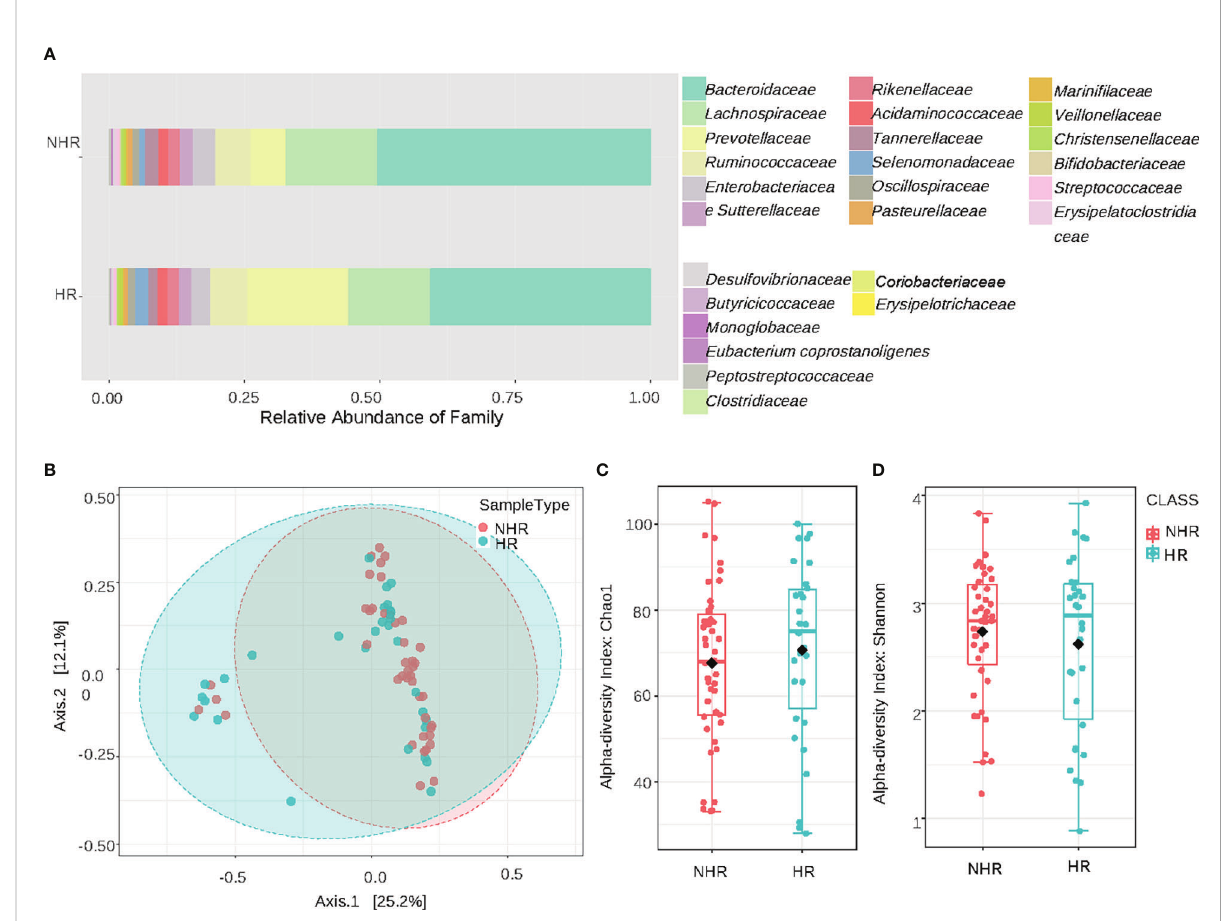
FIGURE 1 Results of diversity and taxonomy. (A) At the family level,the stacked bar plots; (B) Result of b -diversity visualized using principal coordinate analysis based on Bray-Curtis Index (Permutational MANOVA test, F= 1.8078, R2= 0.02483, p<0.066); (C, D) The plots of a -diversity: (C) The chao1 -diversity boxplots (T-test, p= 0.51802). (D) The shannon index boxplots (T-test,